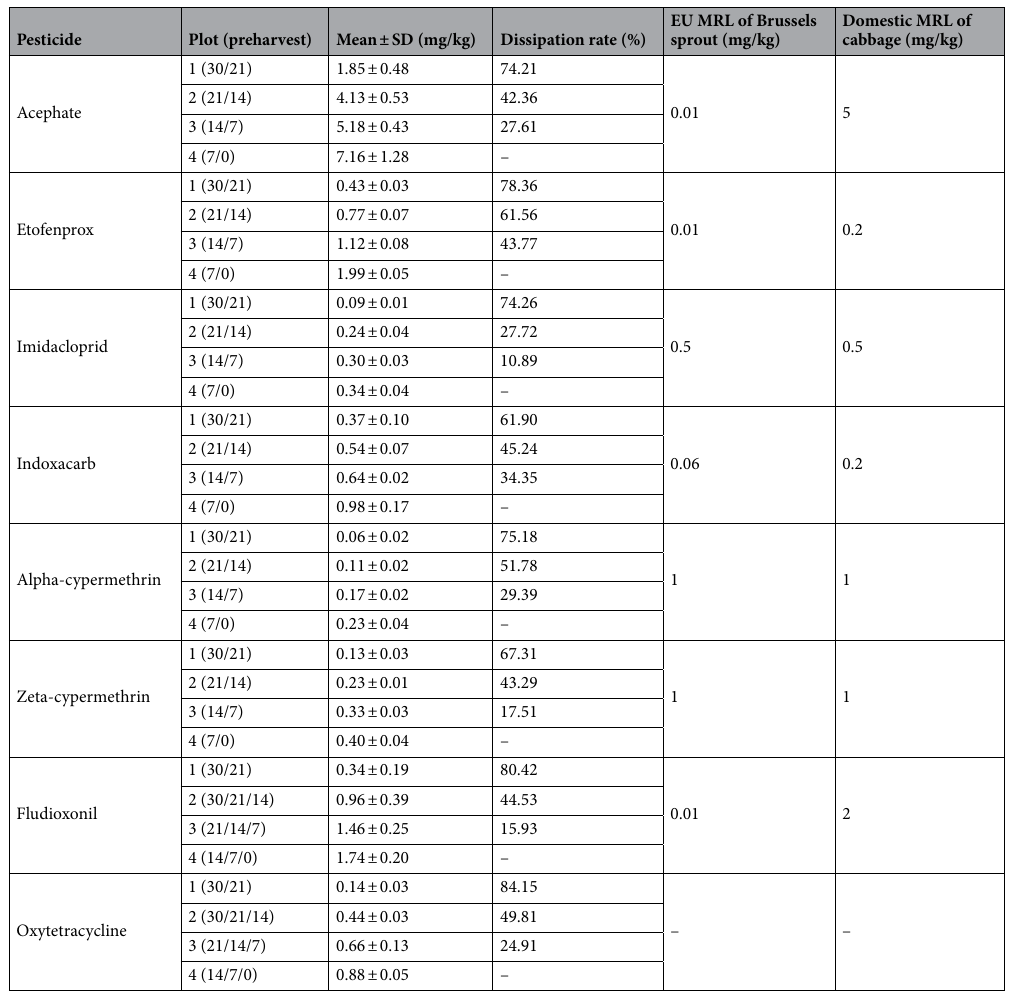
Table 2. Average residues and dissipation rates of eight pesticides in Brussels sprout. SD standard deviation, EU European Union, MRL maximum residue limit.